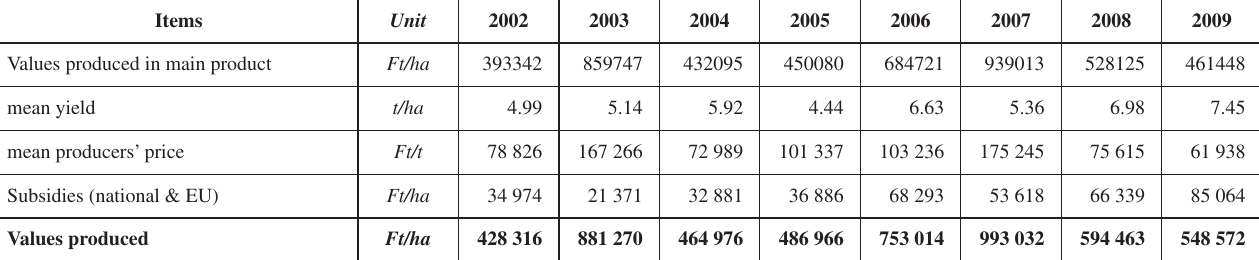
Table 1. Values produced of sour cherry on farms relevant to market